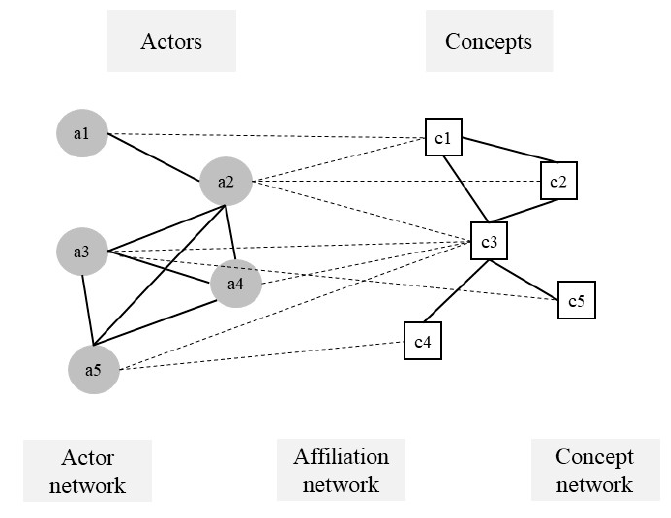
Figure 2. Discourse networks.